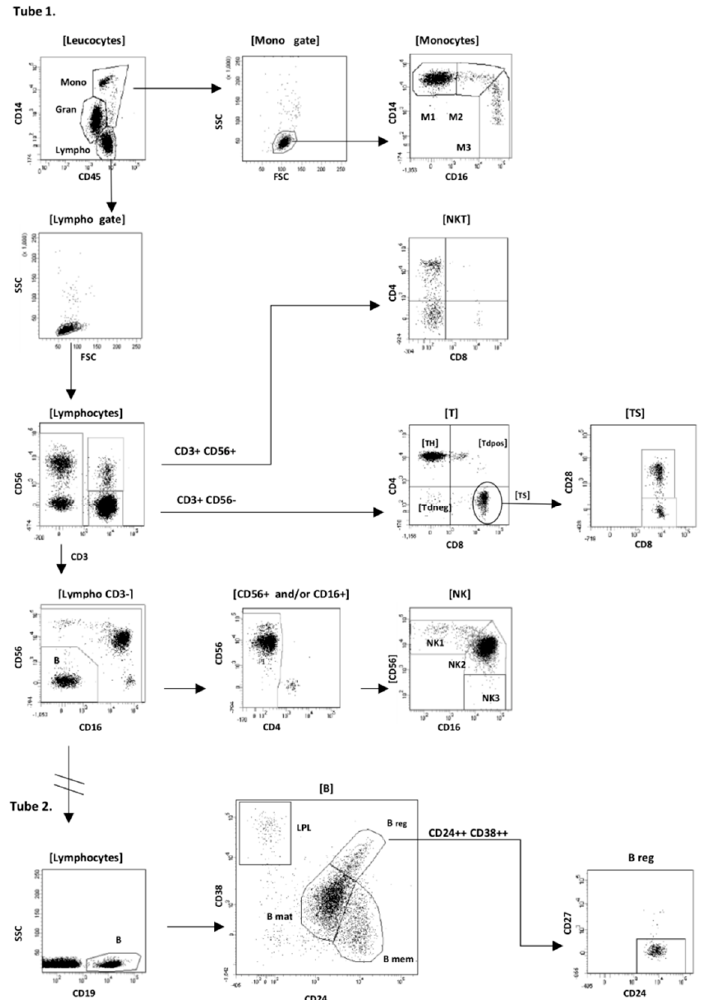
Figure 1. Gating strategy used in the study for immune cells identification. Example of gating strategy for multiparameter flow cytometry analysis of subpopulations of peripheral blood leucocytes of a healthy donor. The first step of analysis was common for both tubes: viable CD45 + leucocytes without debris and doublets were displayed on CD45 / CD14 dot plot, and gates for monocytes, lymphocytes, and additionally (not analyzed here) granulocytes were gated as shown. Next, the ‘back-gating strategy’ (on FSC / SSC dot plot) was used to purify monocytes (Mono gate) and lymphocytes (Lympho gate) from unwanted cells. Tube 1: Subpopulations of monocytes and NKT, T, and NK cells were examined. For monocytes-classical (M1), intermediate (M2), and non-classical (M3) subpopulations were separated. Lymphocytes were divided into CD3 + and CD3 − fraction. In the CD3 + fraction, CD3 + CD56 + cells (the negative expression of CD16 was not shown) were designated as NKT cells, and CD3 + CD56 − cells were designated as ‘true’ T lymphocytes. On the basis of the co-expression of CD4 and CD8 antigens, four subpopulations of T lymphocytes were established: T helper CD4 + CD8 − (T H ), T suppressor CD4 − CD8 + (Ts) with CD28 − and CD28 + cells, T double negative CD4 − CD8 − (T dneg ), and T double positive CD4 + CD8 + (T dpos ). NK cells were selected from CD3 − fraction as CD56 + and / or CD16 + cells, with CD56 bright CD16 − / + subpopulation (sign as NK1 gate on the scheme), CD56 dim CD16 + cells (NK2 gate), and rare CD56 − CD16 + cells (NK3 gate). Additional CD4 / CD56 dot plot was previously used to remove residual dendritic cells from NK3 gate. The subpopulation of CD3 − CD56 − CD16 − cells consisting of B lymphocytes (CD19 + ) was analyzed more precisely in Tube 2. Tube 2: CD19 + lymphocytes from Lympho gate were displayed on CD24 / CD38 dot plot, and the following main B subpopulations were gated: B regulatory CD38 bright CD24 bright CD27 − (B reg ), B mature CD38 dim CD24 dim (B mat ), B memory CD38 − CD24 bright (B mem ), and lympho-plasmocytes CD38 bright CD24 − (LPL).